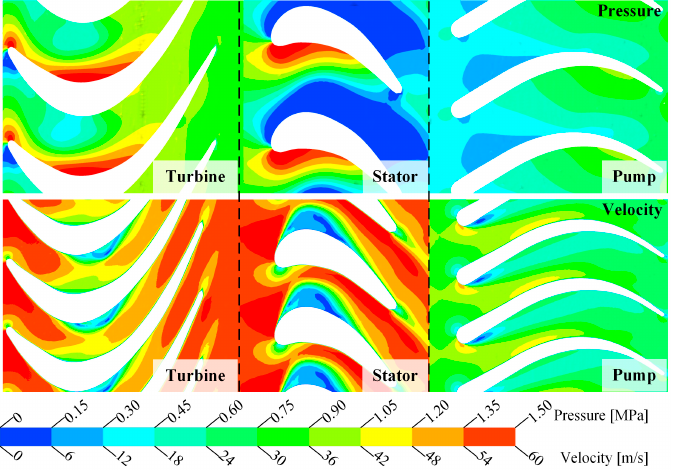
Figure 10. The absolute pressure and velocity nephogram in torque converter at stall when N P = 3000 rpm.